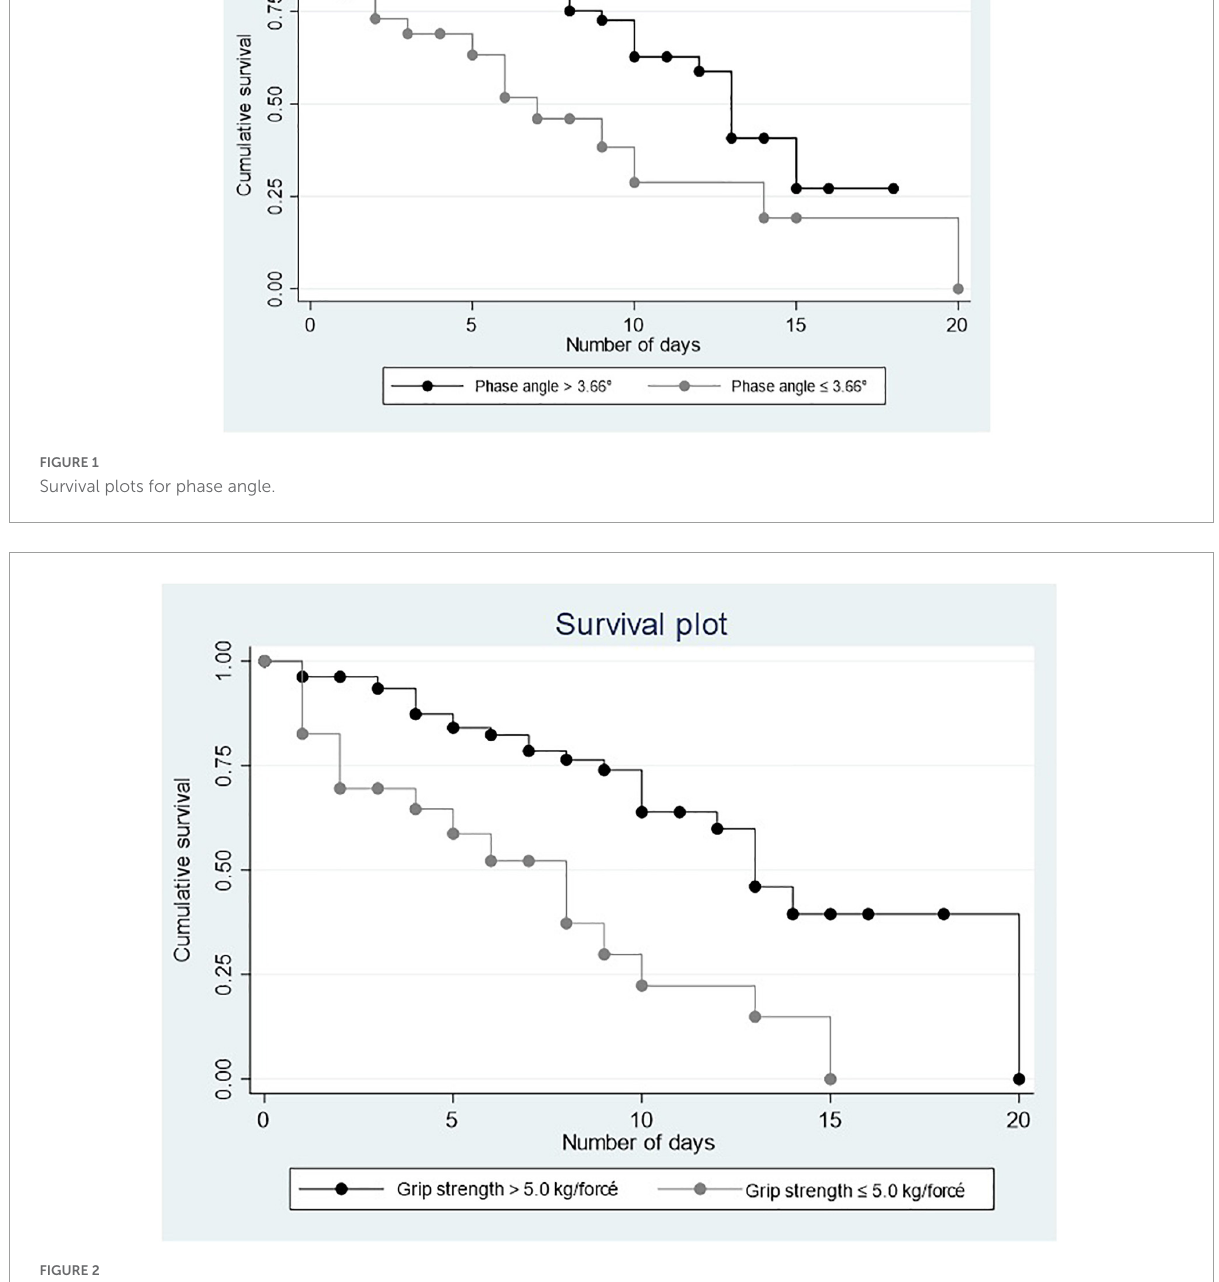
FIGURE2 Survival plots for muscle